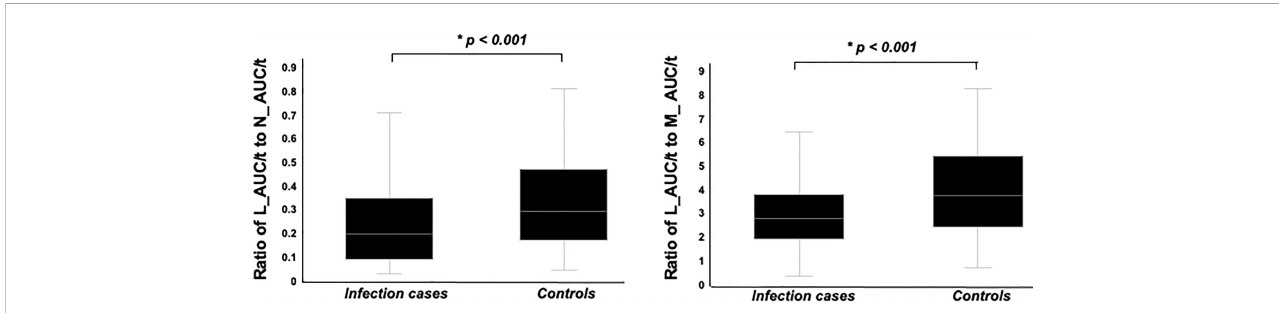
FIGURE 5 Comparison of ratio of L_AUC/t to N_AUC/t and ratio of L_AUC/t to M_AUC/t between infection cases and controls. Both were signi fi cantly lower in infection cases than